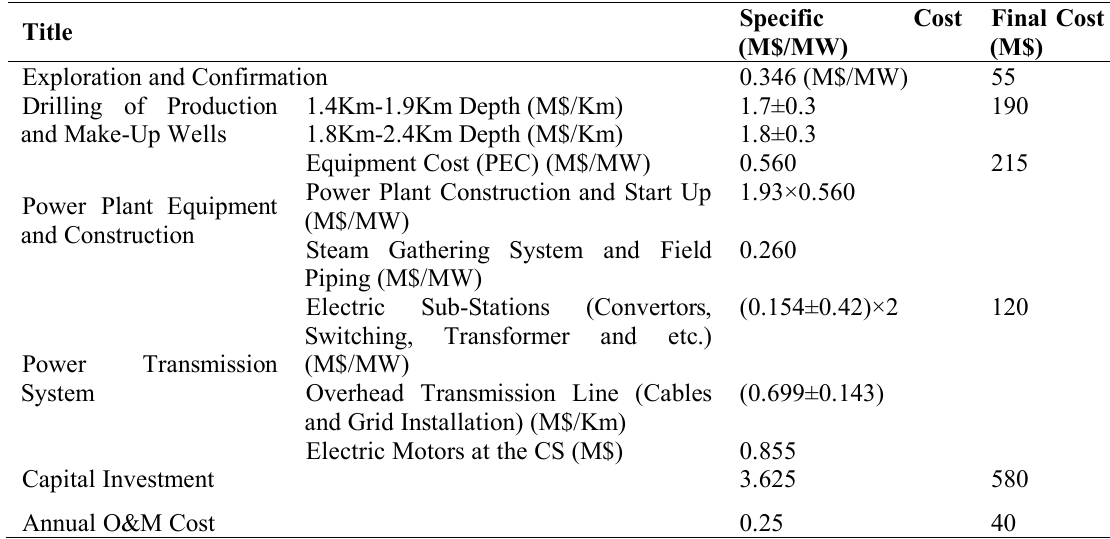
Table 14 . Initial investment and annual cost of a160MW double-flash power plant on Mahallat- Isfahan reservoir